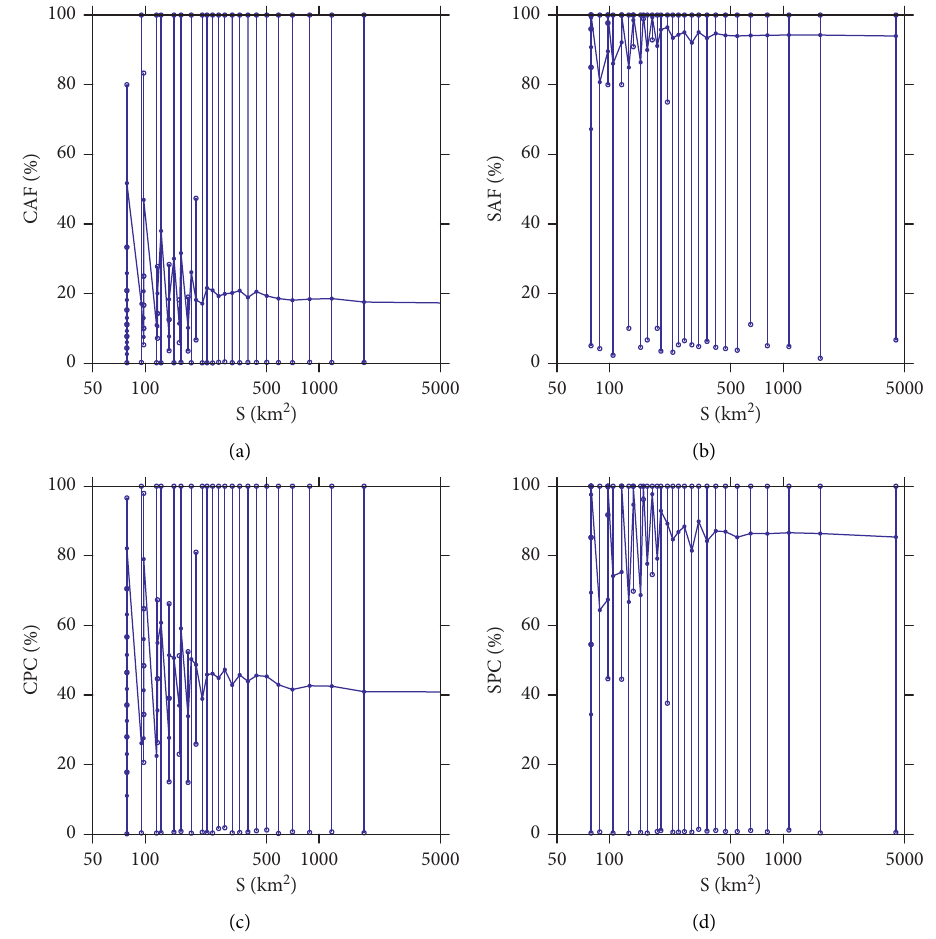
Figure 12: The relationship between CAF and S (a), SAF and S (b), CPC and S (c), and SPC and S (d) on Tibetan Plateau from 1998 to 2015 based on the statistical principle of same samples in each interval at x